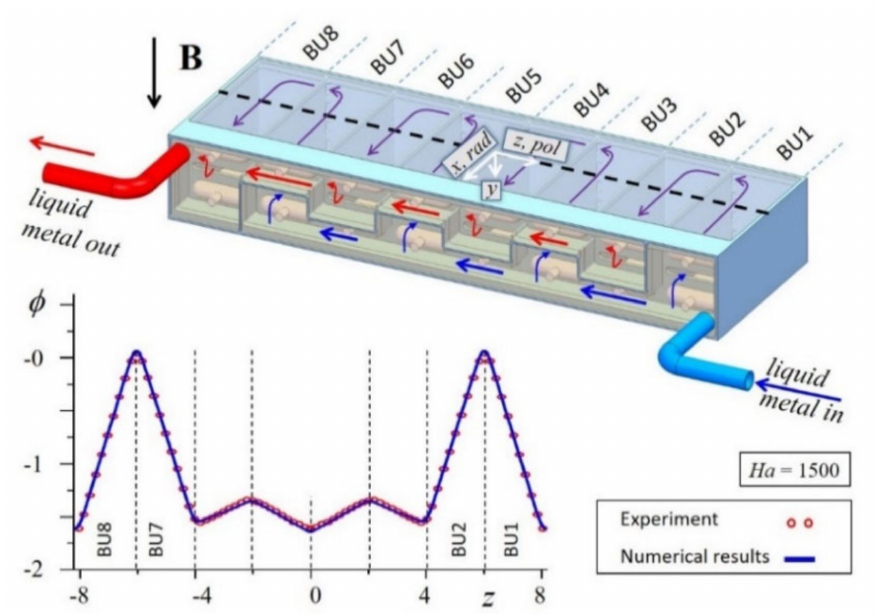
Figure 7. Sketch of liquid metal flow paths in an experimental MHD mock-up of a HCLL TBM for ITER. Nondimensional results for measured electric potential φ (symbols) along the upper wall (dashed line) are compared with numerical simulations (solid